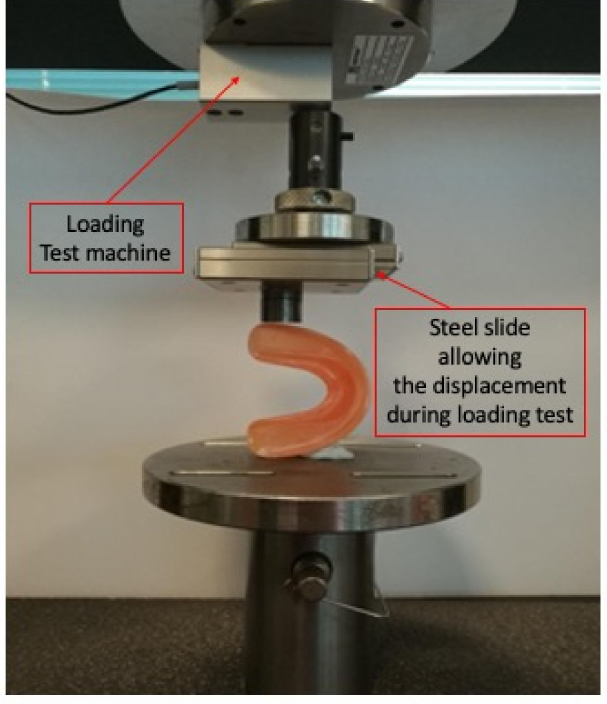
Figure 3. Example of appliance positioning in the mechanical test machine. The research experimental workflow is represented in Figure 4.